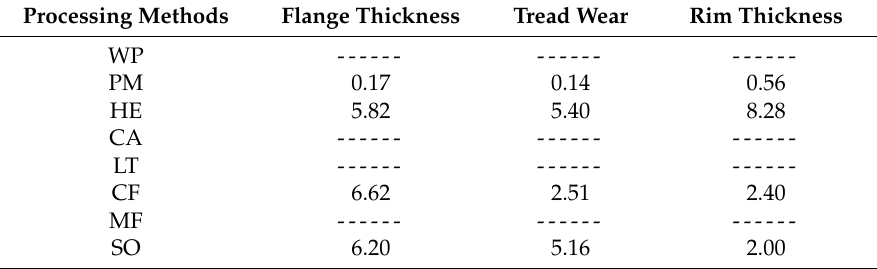
Table 4. Measurement accuracy of wheel size by using different methods (mm).